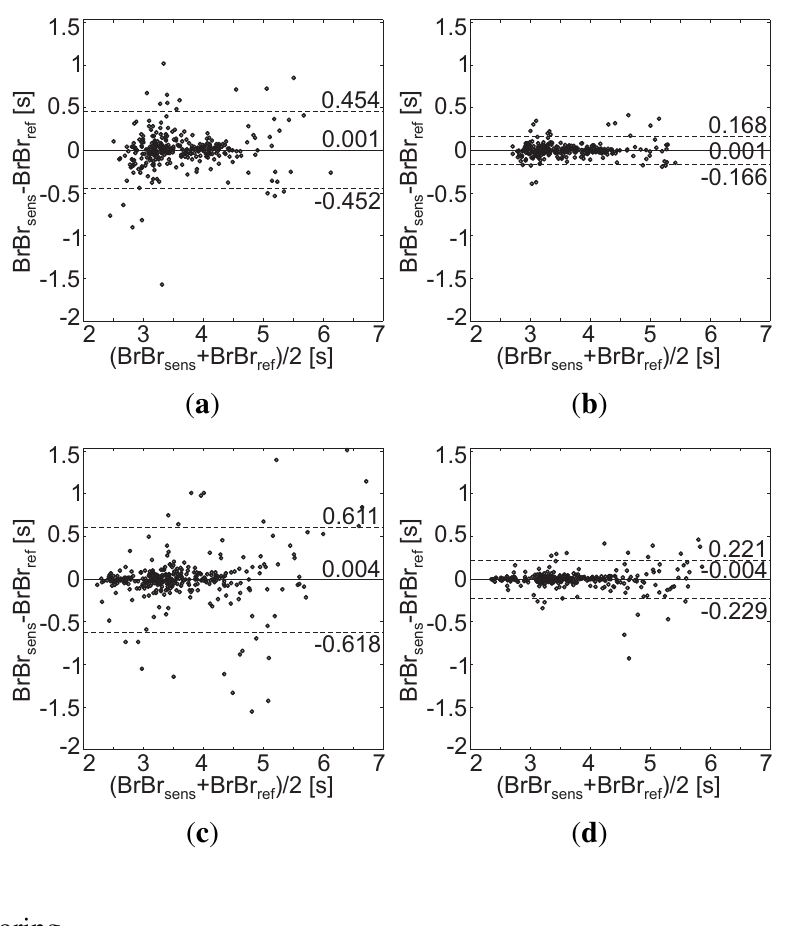
Figure 9. Bland–Altman plot of the breath-to-breath intervals, BrBr recorded by the MAIN Shirt and the reference sensor, respectively, during normal breathing in ( a , b ) standing and ( c , d ) sitting posture. (a,c) Non-smoothed values obtained from the raw signal; (b,d) values smoothed by a sliding average of three elements.